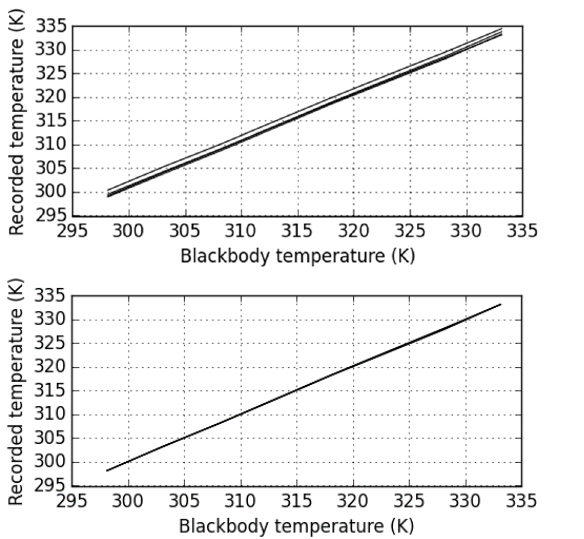
Figure 5. Mean image values of a blackbody heated to a wide range of temperatures; R 2 = 0.99995, p < 0.001. Imagery of the blackbody at 25 °C and 60 °C have been used to calculate the gain and the bias of each detector across the array. In order to minimise the difference in offsets between different pixels of the imagery observed over time, averages of ten pictures of the blackbody were used. The gain and offset matrices were then used to calibrate all the detectors across the array so that they produce a radiometrically accurate and uniform reading at the two reference temperatures, as presented in Figure 6.